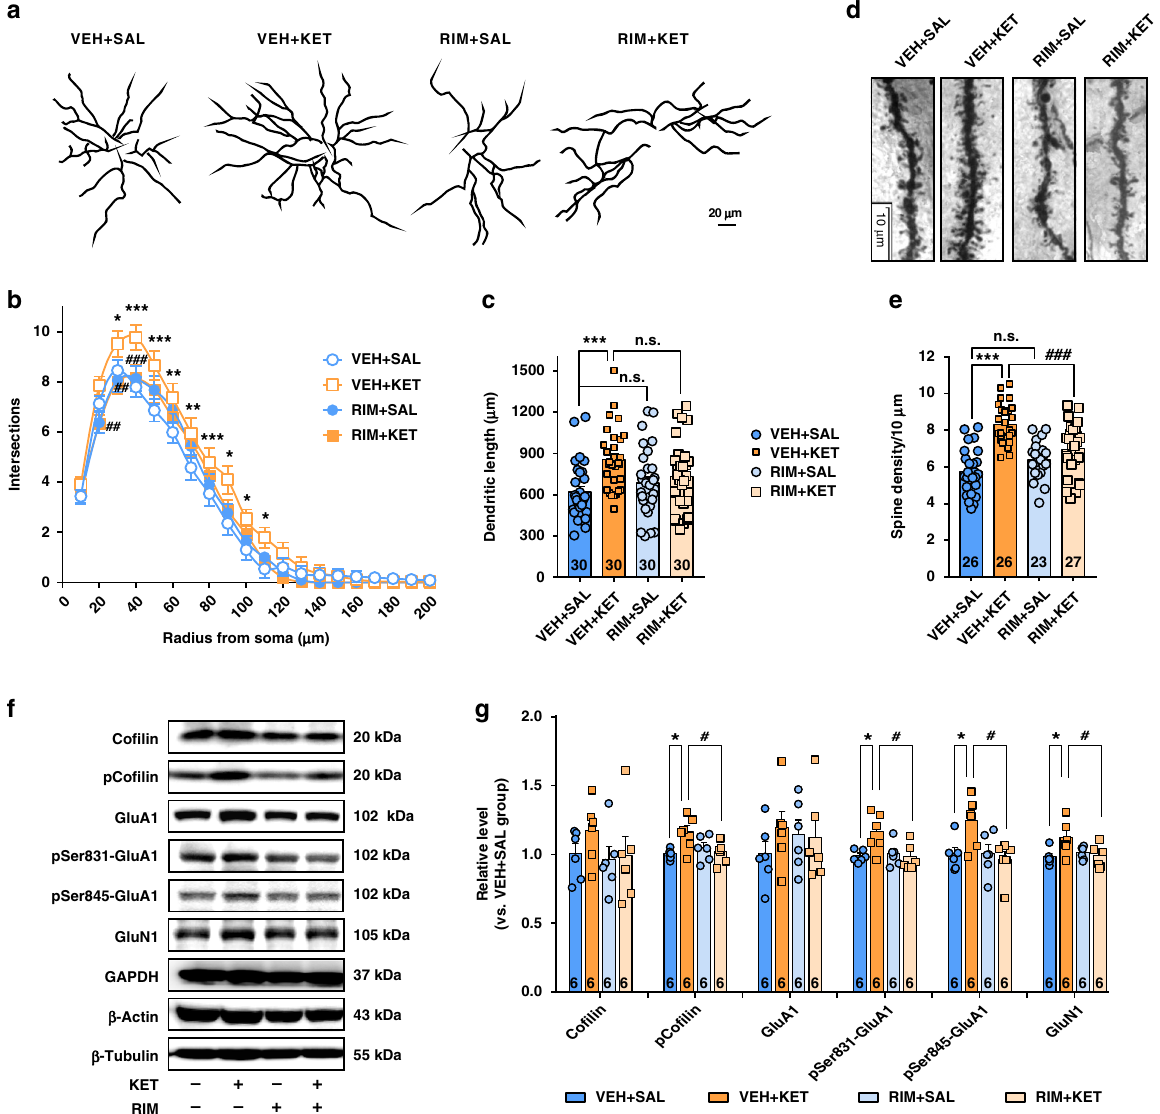
Fig. 3 Ketamine remodels dendrite structure in the DLS in hyperlocomotion paradigm by a CB1R-dependent manner. a Representative traces of Golgi – Cox-stained DLS SPNs. b CB1R blockage partly inhibited ketamine-induced dendritic arborization ( n = 30 neurons/group, two-way repeated measured ANOVA, followed by Tukey ’ s multiple comparisons test, treatment, F (3,87) = 3.203, P = 0.0272; radius, F (19,551) = 427.7, P < 0.0001; interaction, F (57,1653) = 1.554, P = 0.0056). c CB1R blockage did not reduce dendritic length promoted by ketamine (one-way ANOVA, followed by Tukey ’ s multiple comparisons test, F( 3,116) = 5.448, P = 0.0015; VEH + SAL vs. VEH + KET, P = 0.0009). d Representative images for dendritic spines of